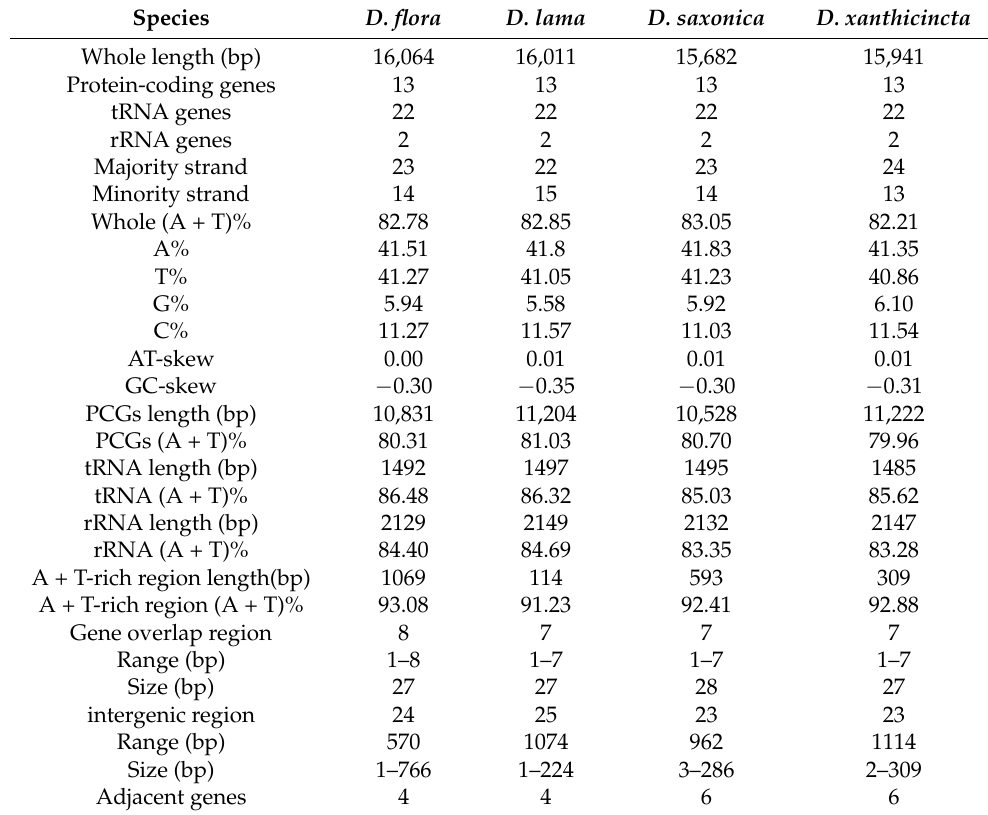
Table 1. General features of the genomes of the four Dolichovespula